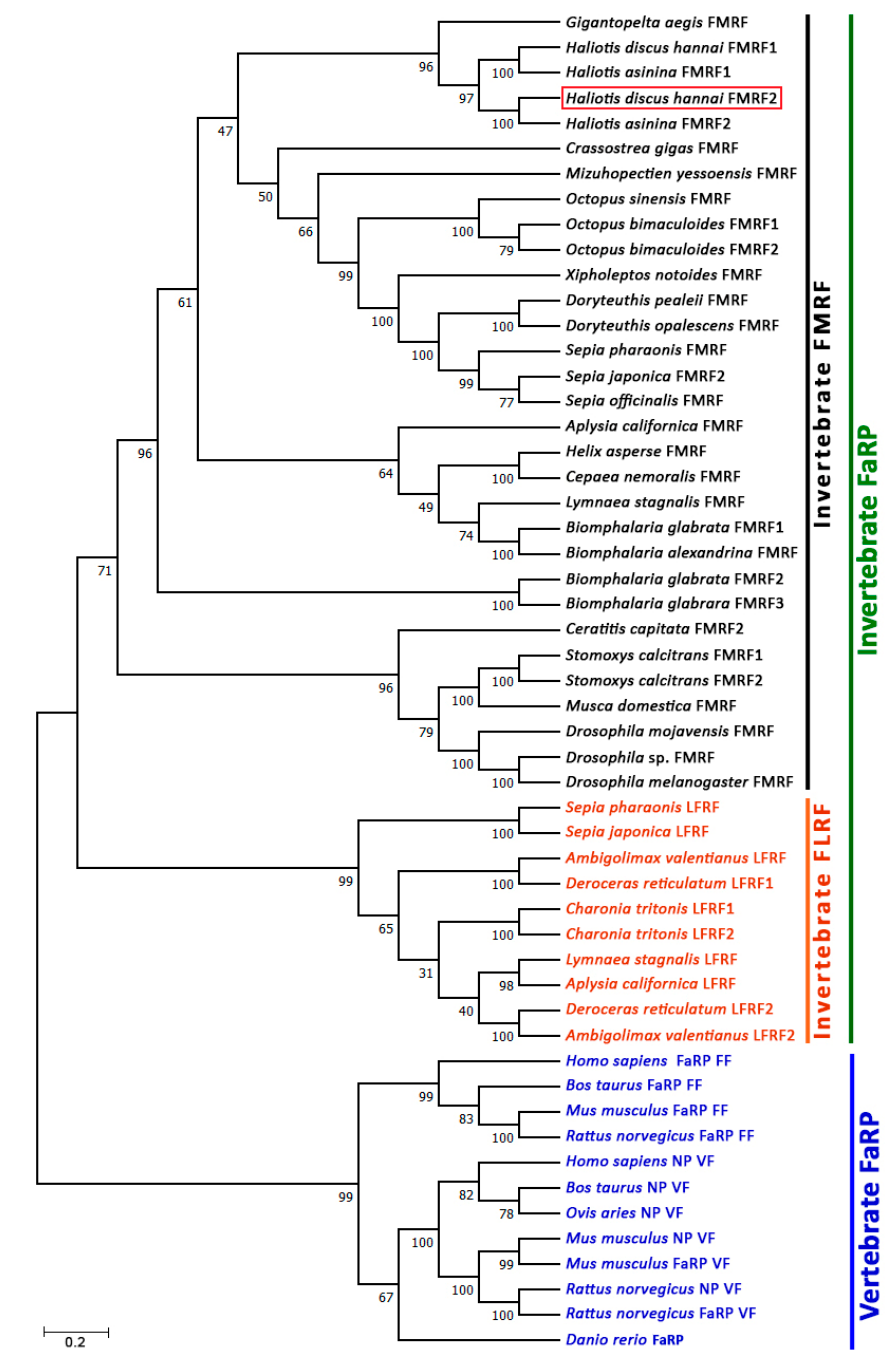
Figure 5. Phylogenetic tree of invertebrate and vertebrate FaRP sequences. Phylogenetic analysis of 53 FaRP amino acid sequences was performed by the bootstrap neighbor-joining method with 1,000 bootstrap replicates after aligning the amino acid sequences of FaRPs using the MUSCLE alignment option. The numbers at the nodes indicate bootstrap probability. The scale bar indicates 0.2 units of the expected fraction of amino acid substitutions (1.0 unit = 100 PAMs). The FaRP sequences infor- mation used to construct the phylogenetic tree are presented in Supplementary Table S3.